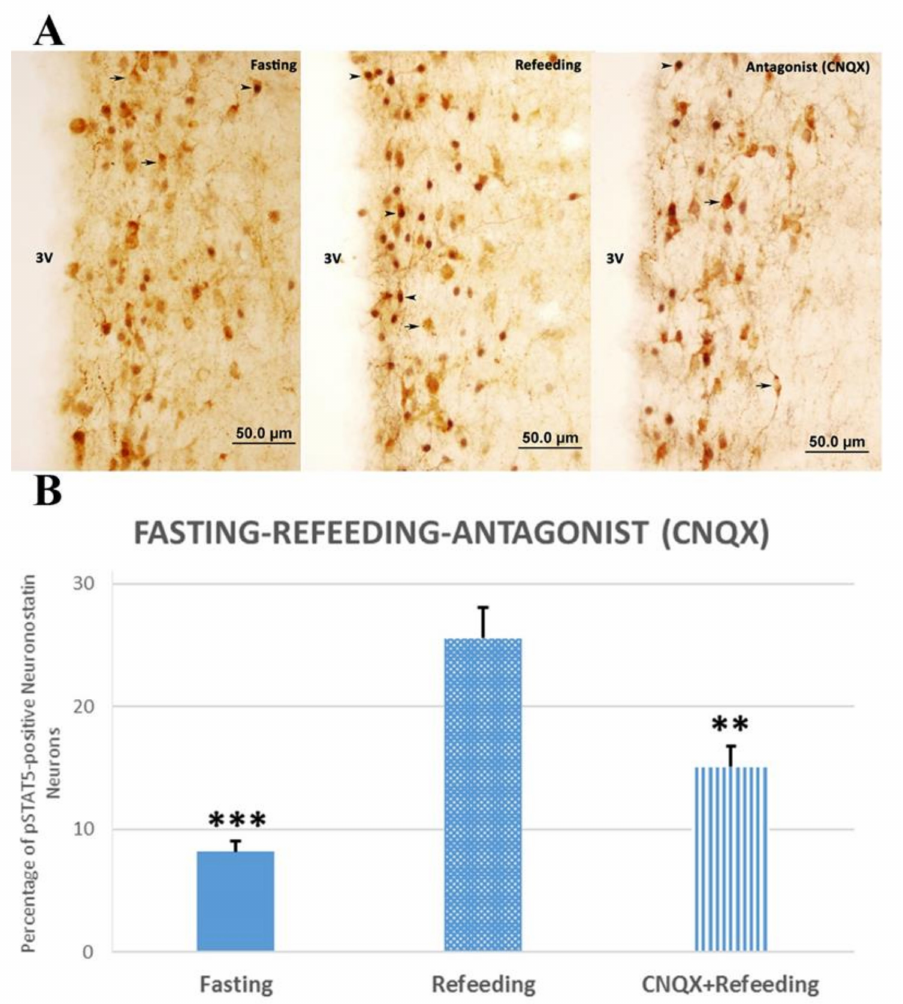
Figure 3. The e ff ect of CNQX, a non- N-methyl-D-aspartate (NMDA) glutamate antagonist, in subjects Brain Sci. 2020 , 10 , x FOR PEER REVIEW stimulated by refeeding after fasting. There were significant di ff erences between fasting-refeeding groups (*** p < 0.001) and refeeding-antagonist groups (** p < 0.01) ( B ). pSTAT5 expression in neuronostatin neurons after 48 h fasting (on the left), pSTAT5 expression in neuronostatin neurons activated with refeeding in anterior hypothalamic periventricular nucleus (in the middle), neuronostatin neurons in the anterior periventricular nucleus in CNQX-treated subjects before feeding (on the right) ( A ). pSTAT5 protein-expressing neuronostatin neurons ( ▲ ) and pSTAT5-negative neuronostatin neurons ( ). 3V: third (